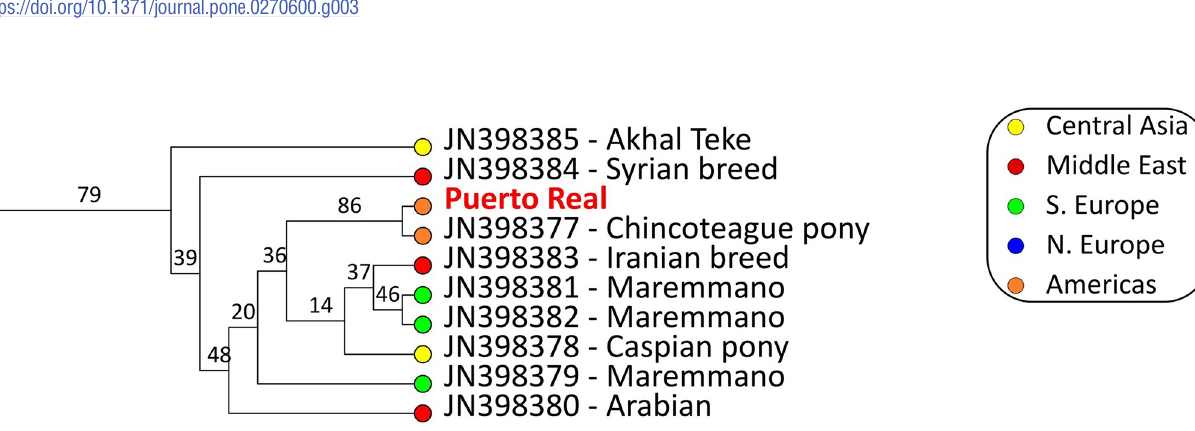
PLOS ONE | https://doi.org/10.1371/journal.pone.0270600 July 27, 2022 9 /